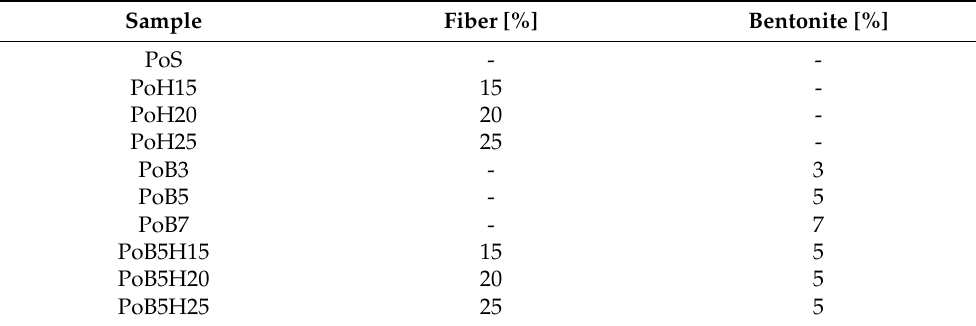
Table 3. Denomination and composition of the prepared samples.